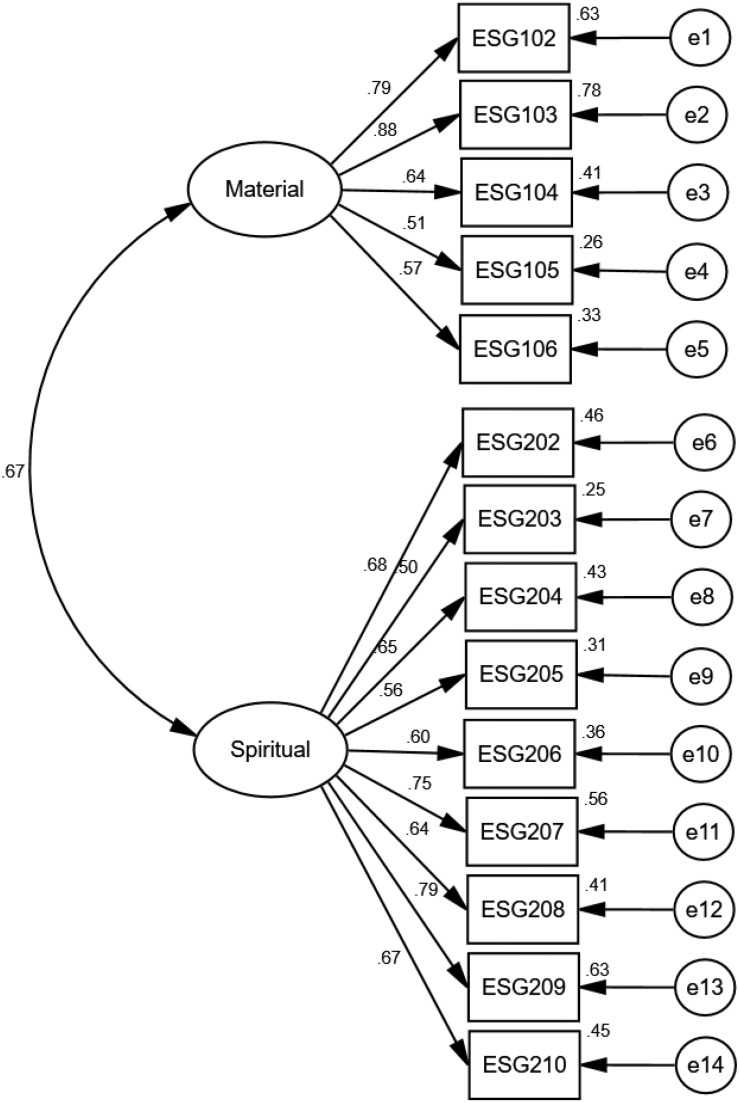
Standardized path diagram for two-dimensional structural equation model of ESG.